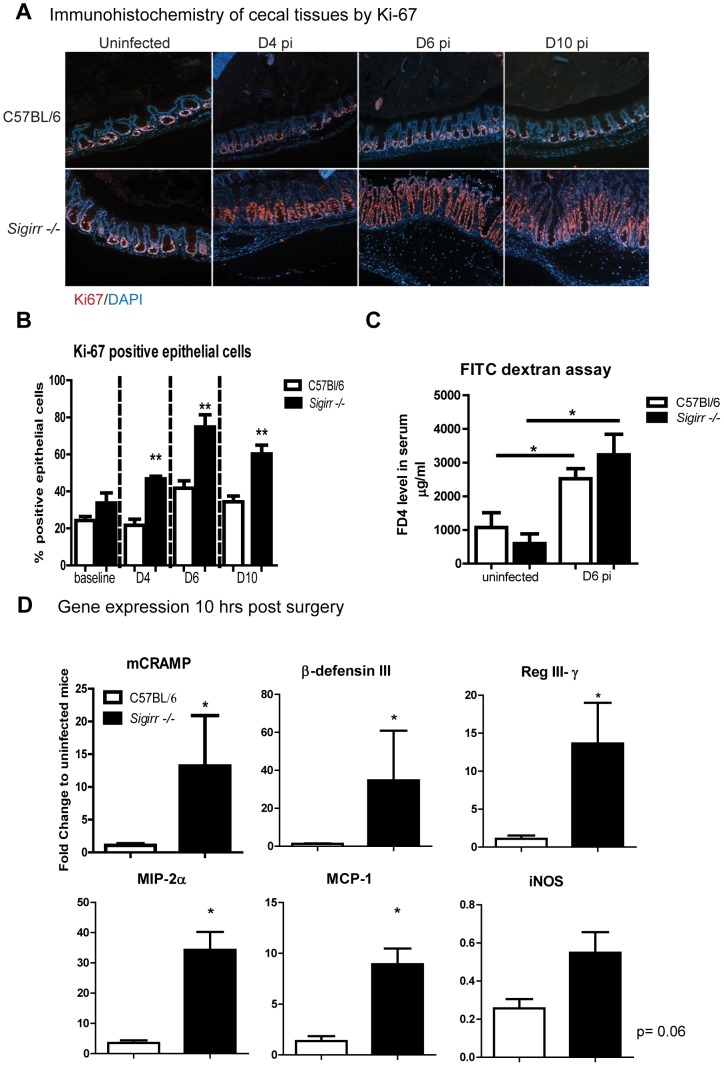

Sigirr −/− mice exhibit stronger inflammatory responses during C. rodentium infection.Immunostaining for the proliferation marker (A) Ki-67 (red) revealed Sigirr −/− mice exhibit increased IEC proliferation in cecal tissues by D4 pi. (B) At D4, D6 and D10 pi, there are significantly more proliferating IEC in Sigirr −/− mice compared to WT mice. (C) WT and Sigirr −/− mice experience similar levels of barrier permeability following infection. (D) Sigirr −/− mice carry significantly higher gene transcript levels for antimicrobial peptides and chemokines compared to WT mice following cecal loop surgery. Results are representative of 4 independent infections with n = 3–4 per group. Error bars = SEM, (Student t test (Figure B and C), Mann-Whitney t test (Figure D), *P<0.05, **P<0.01).